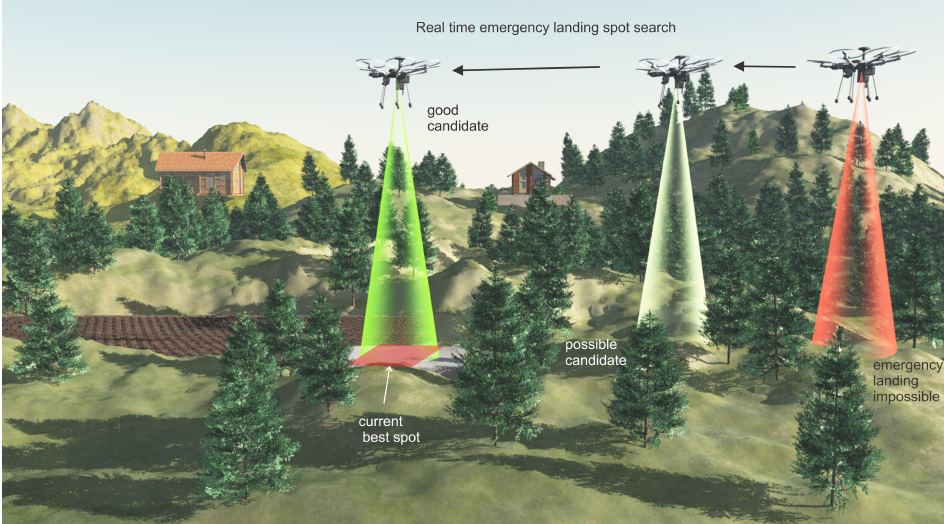
Figure 1. Conceptual approach for emergency landing spot detection with a